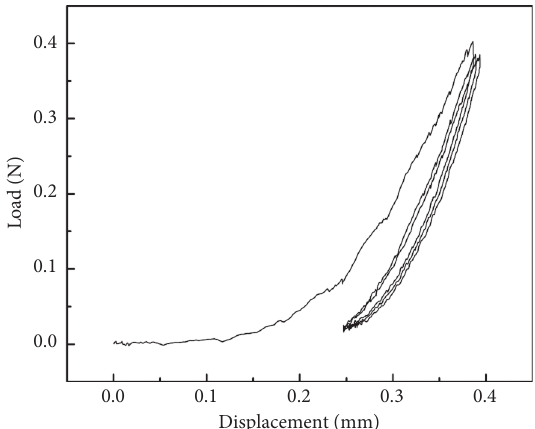
Figure 1: Load-displacement curve during the preconditioning process.